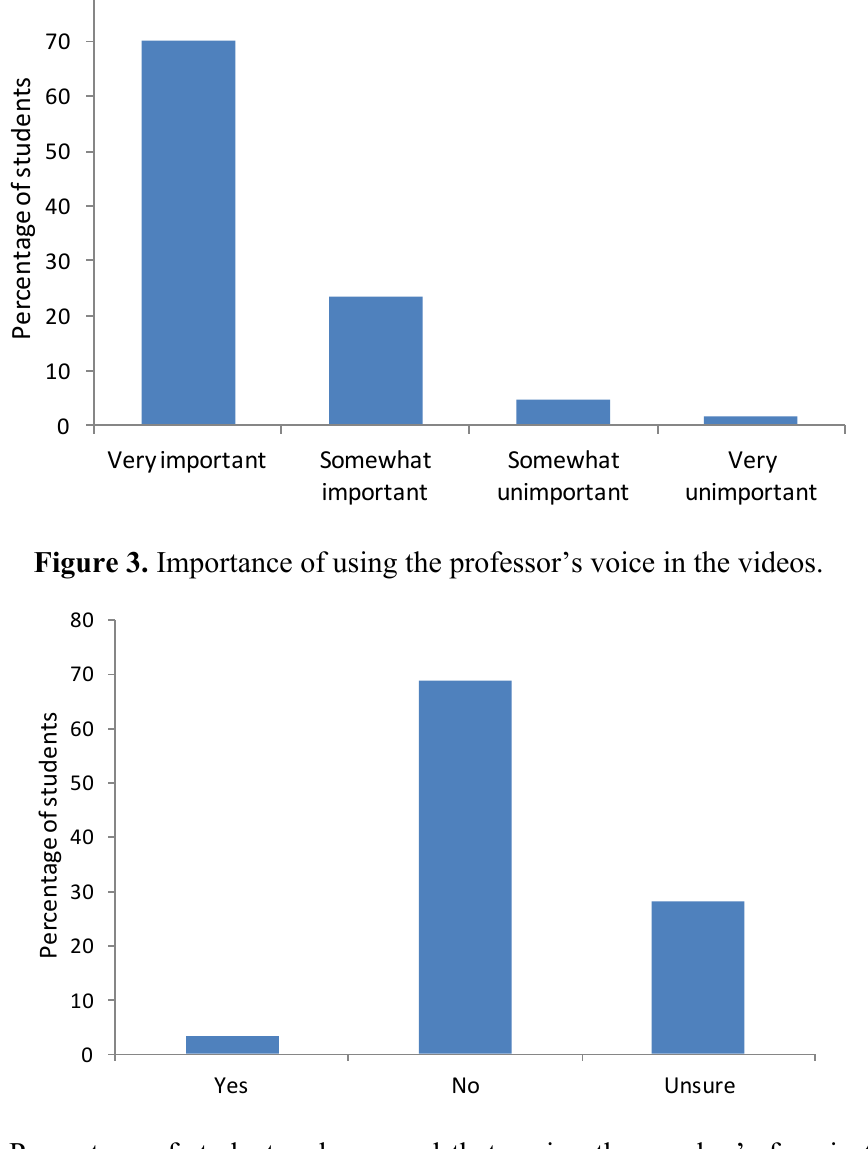
Figure 4. Percentage of students who agreed that seeing the speaker’s face in the video would improve their learning